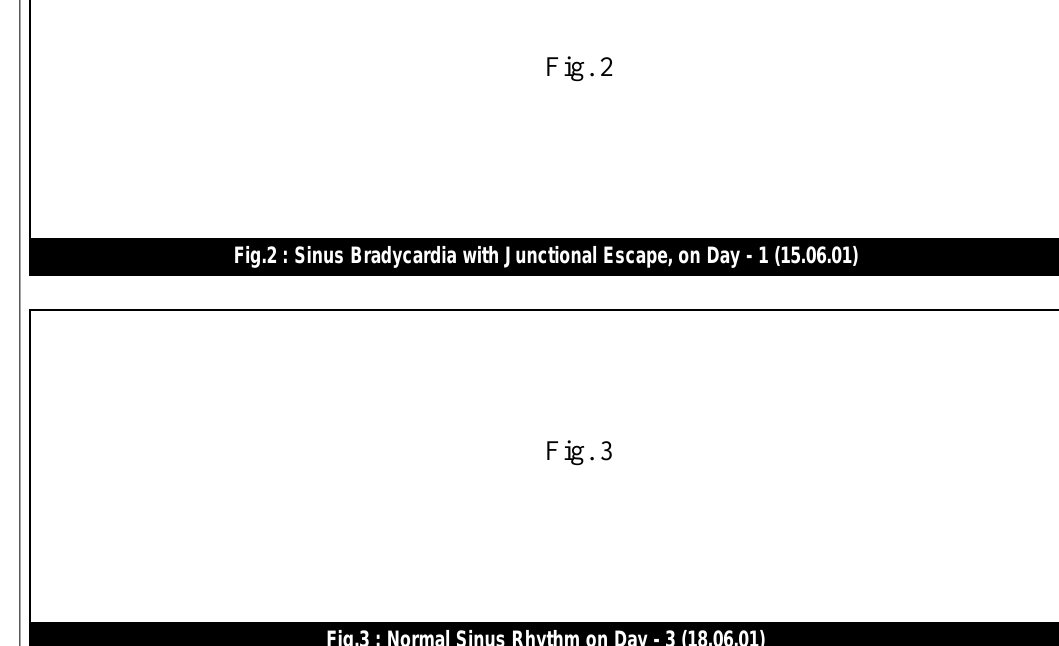
Fig.1 : Complete AV Dissociation, on Day - 1 (15.06.01)